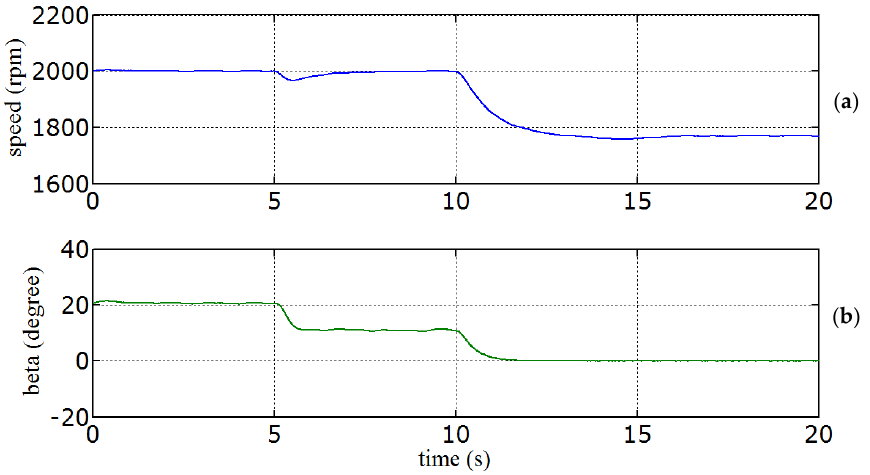
Figure 7. Operation at variable load and constant wind speed [( a ) rotational speed; ( b ) pitch angle]. At t = 5 s, a 1 MW load is applied to the generator. In order to supply such load the blade pitch angle is decreased, increasing P m while maintaining maximum rotational speed (see Figure 7).